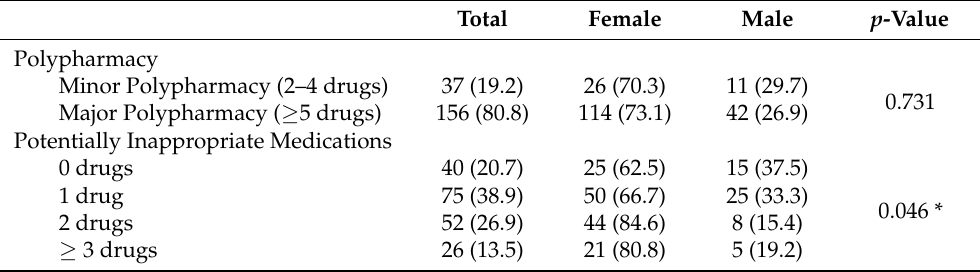
Table 2. Polypharmacy and potentially inappropriate medications (PIMs) by